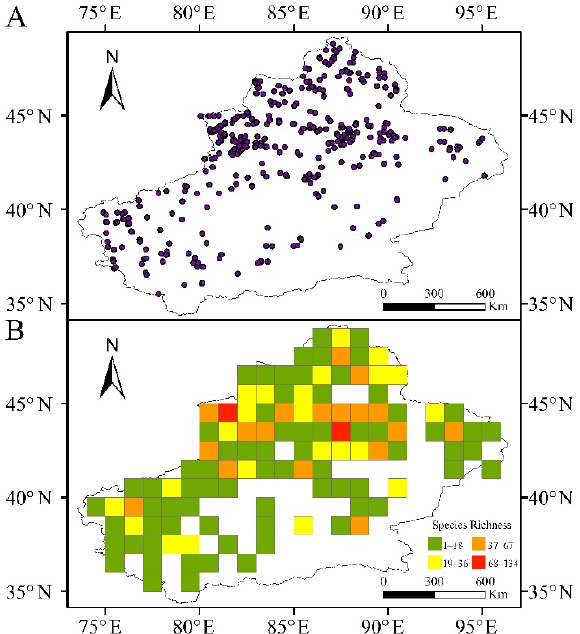
Figure 2. ( A ) The general distribution pattern of Tenebrionidae in Xinjiang, China. ( B ) The species richness pattern identified by a 1° grid size in Xinjiang, China.